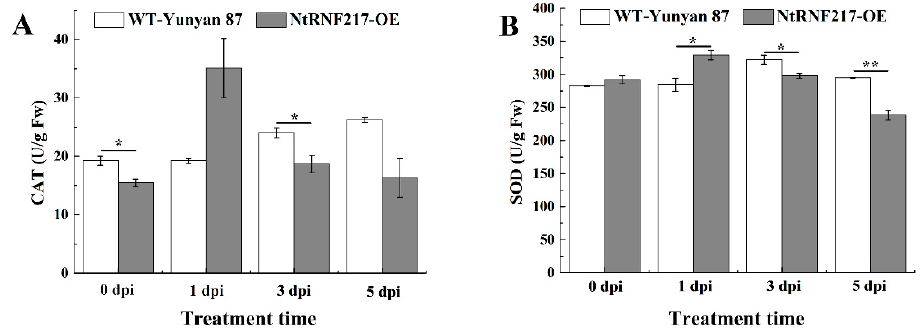
Figure 6. The activities of CAT and SOD in WT-Yunyan87 and NtRNF217 -OE plants after inoculation with 10 mL Ralstonia solanacearum suspension (approximate 10 8 CFU mL − 1 ). ( A ) CAT activity. ( B ) SOD activity. dpi means day post inoculation. Error bars indicate the standard error of three overexpression lines. Asterisks indicate a significant difference determined by t -test (* p < 0.05 or ** p < 0.01).